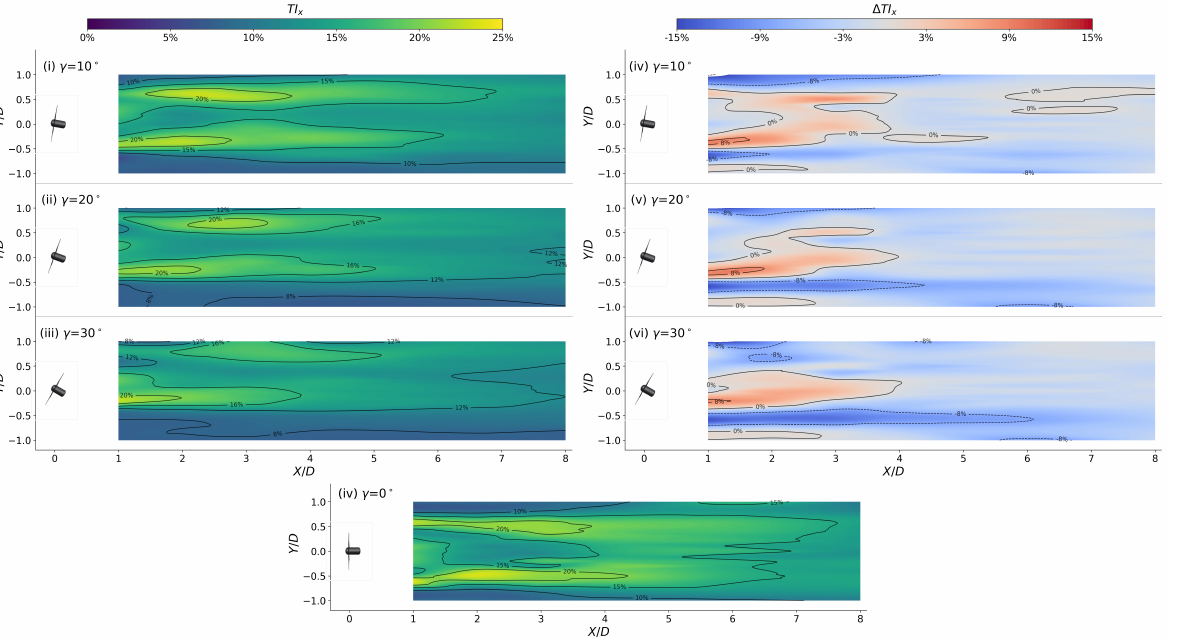
Figure 9. Streamwise turbulence intensity (left) and relative differences (right) between yawed and non-yawed cases of Scenario 1. (i) TI x , γ = 10 ◦ , (ii) TI x , γ = 20 ◦ , (iii) TI x , γ = 30 ◦ , (iv) TI x , γ = 0 ◦ , (v) ∆ TI x = TI x , γ = 10 ◦ − TI x , γ = 0 ◦ , (vi) ∆ TI x = TI x , γ = 20 ◦ − TI x , γ = 0 ◦ , and (vii) ∆ TI x = TI x , γ = 30 ◦ − TI x , γ = 0 ◦ . The quoted distances are downstream of the upstream turbine in all